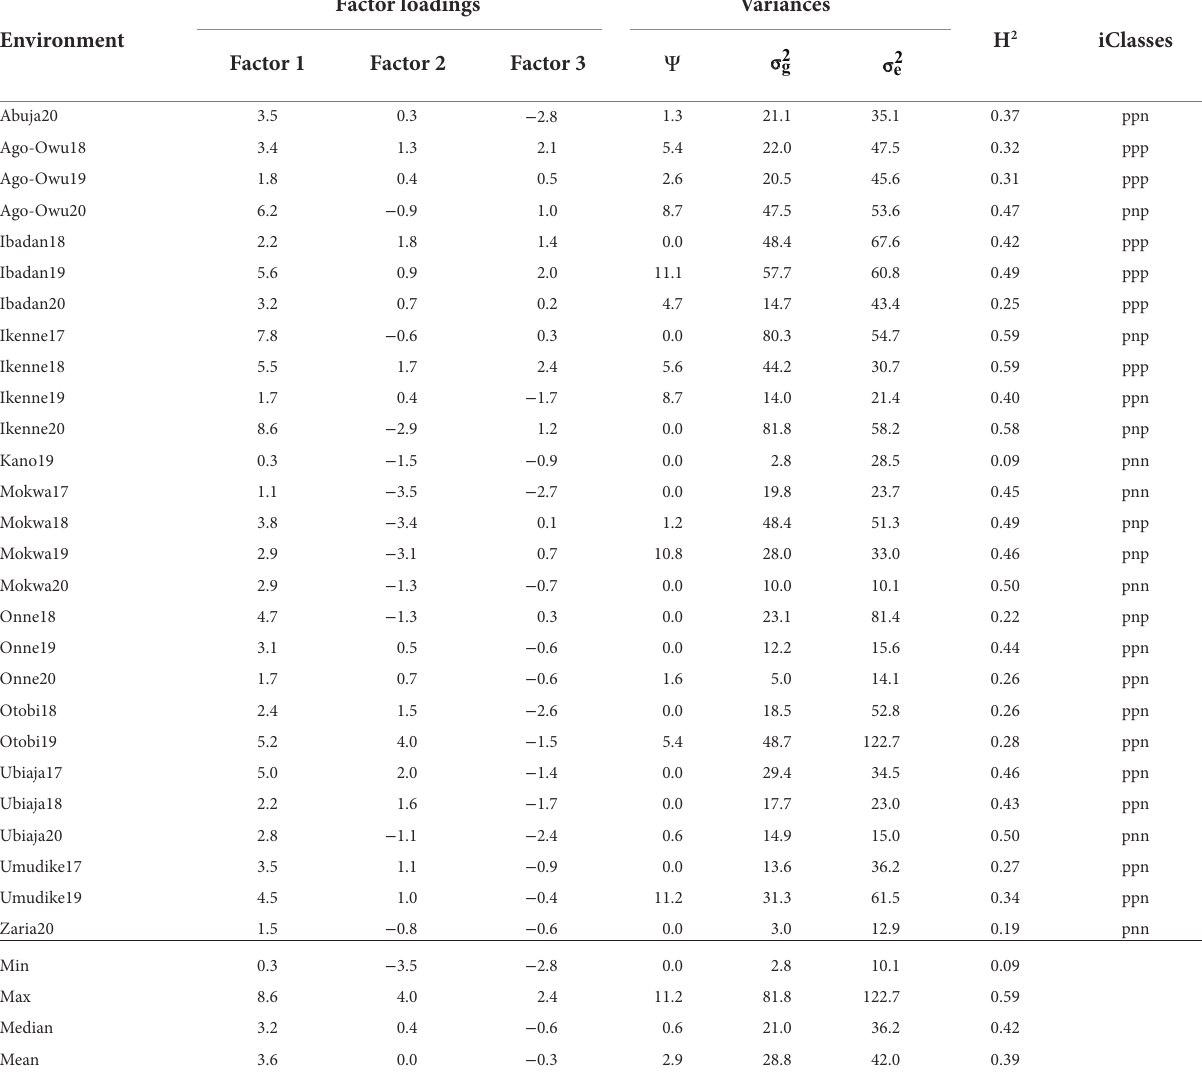
TABLE 3 Summary of the FA3 model in terms of factor loadings, specific variance ( Ψ ) and genetic variances ( ) 2 g σ , error variances ( 2 e σ ), heritability (H 2 ), and interactive classes (iClasses) for environment.